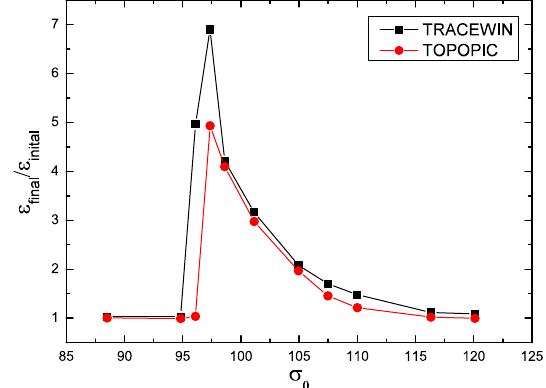
FIG. 1. Simulation results showing the final relative emittance growth for initial parabolic distribution ( η i ¼ 0 . 8 ) with 30 K macroparticles as functions of zero beam current phase advance σ 0